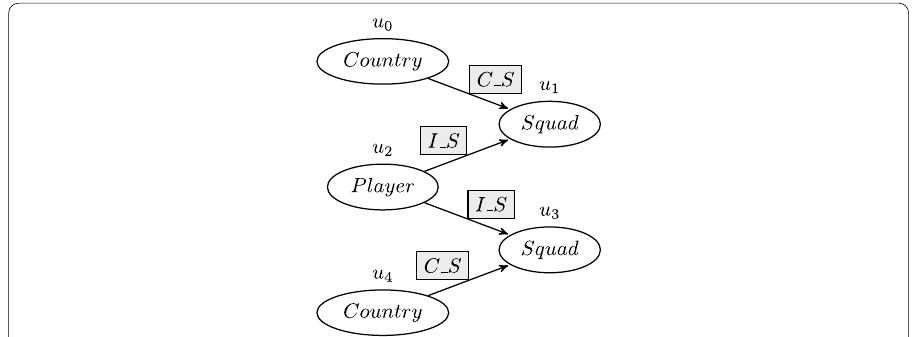
Fig. 6 An example for a path query: “Find the players who join the squad of different countries in WorldCup Database”. The relationship “ C_S ” stands for “ creates squad ” and “ I_S ” stands for “ in squad